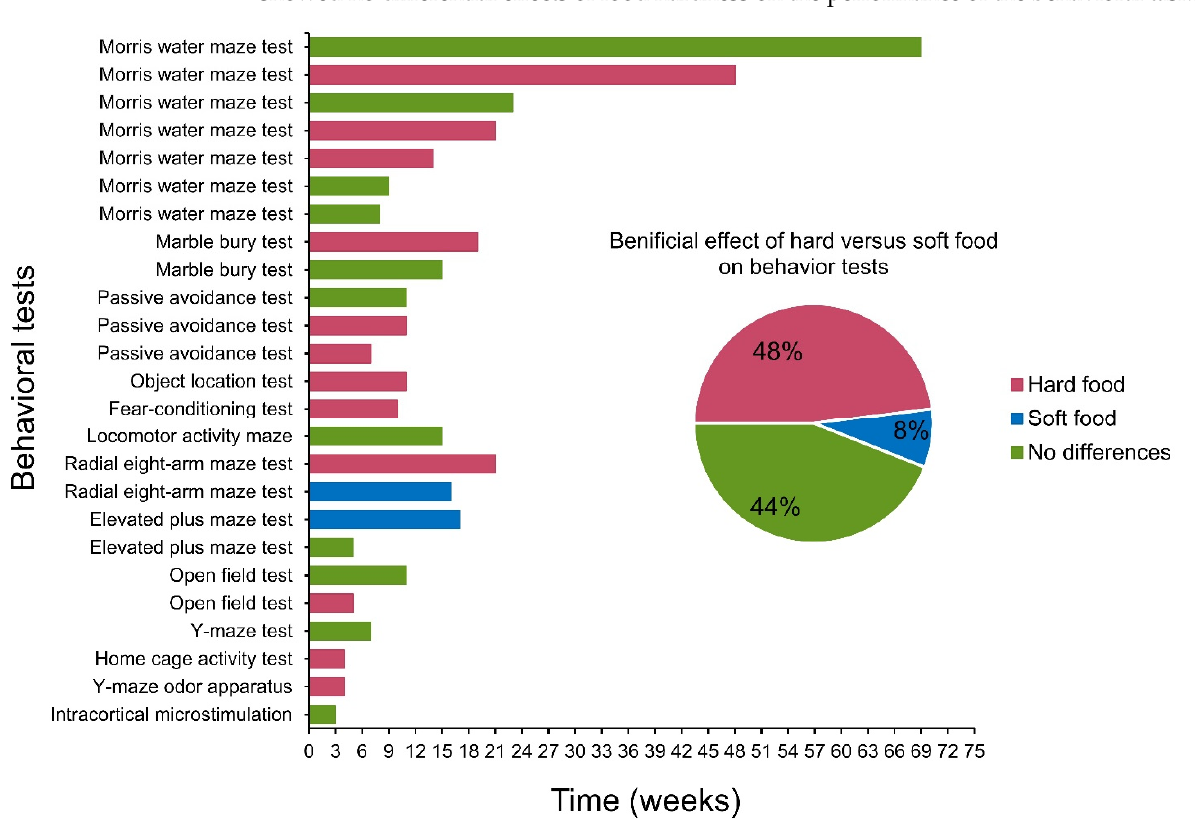
Figure 2. Effect of food dietary hardness on behavioral tests in animal studies.